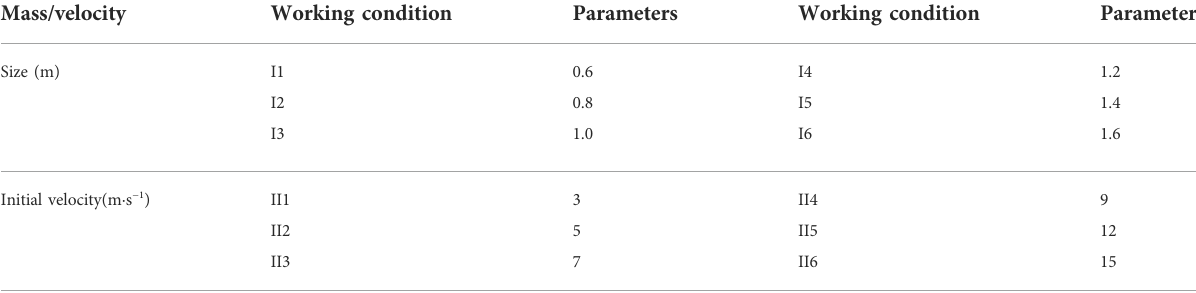
TABLE 3 Distribution of rolling stone conditions with different masses and